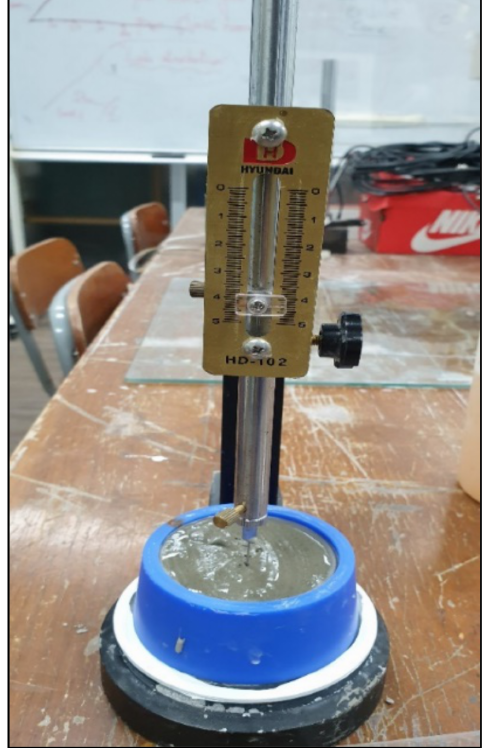
Figure 8. Vicat apparatus for measuring initial setting time. Compressive strength is an important factor. To test the compressive strength of the grout mixes, cubes samples were cast in bronze molds with dimensions of 50 × 50 × 50 mm 3 , as depicted in Figure 9. From the next day onward, the cubes were submerged in water for curing for 28 days. Thereafter, the mean strength values of the grouts were